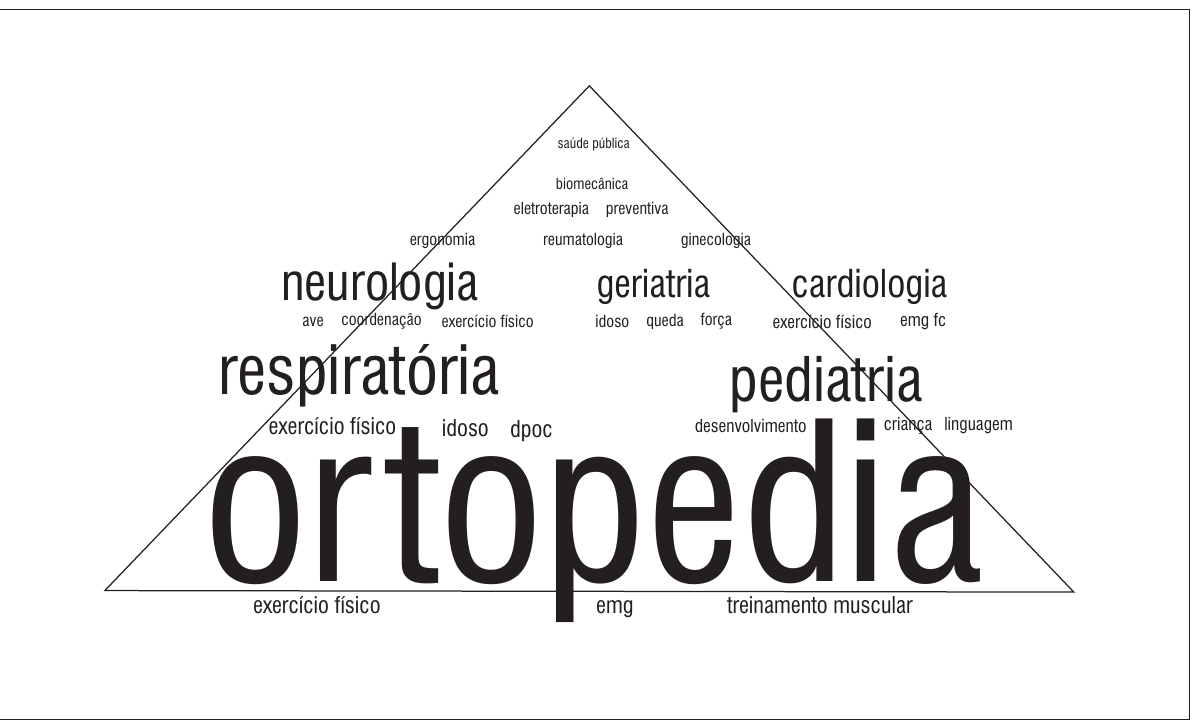
Figura 2 - Pirâmide da base do conhecimento produzido em fisioterapia a partir dos trabalhos de conclusão de curso de Pós-Graduação. O tamanho das palavras representa sua importância em termos de produção em relação ao total das diferentes disciplinas Nota: Abaixo de cada disciplina, estão relacionadas as três mais frequentes palavras relacionadas à disciplina escrita acima. Fonte: Dados da